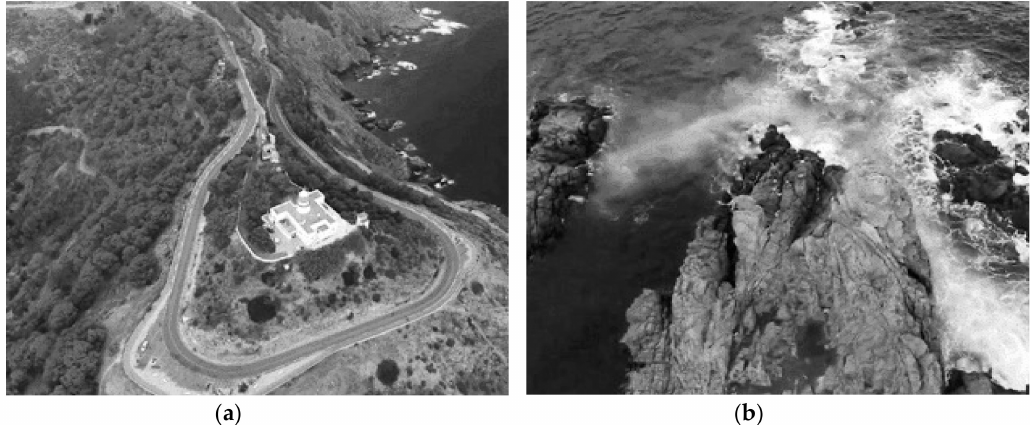
Figure 2. Aerial view of landforms and the coast: ( a ) UAVs allow students to know the complexity of the terrestrial landscape, the characteristics of elevations and depressions in the lithosphere. They also allow in-depth observation of the great forms of the relief: ancient massifs, sedimentary basins, or sedimentary plains and mountain ranges of recent formation. ( b ) UAVs used for remote sensing allow students live knowledge about the two main phenomena of marine erosion: sea currents and waves. Also, this tool makes it possible to know the e ff ects of maritime erosion: cli ff s, abrasion platforms, coastlines, sea caves, and